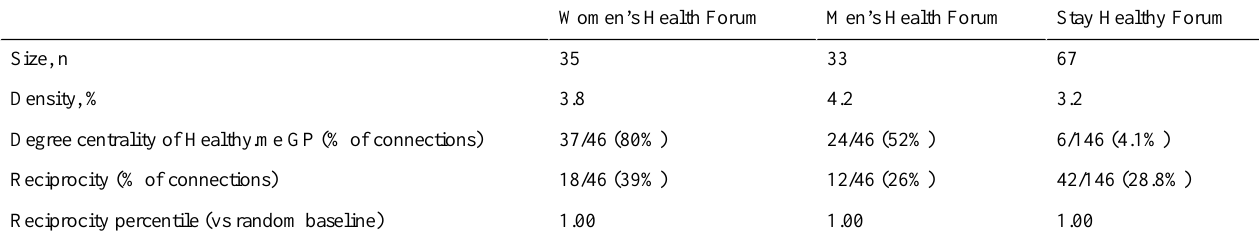
Table 3. Table 3. Social network characterization for the three